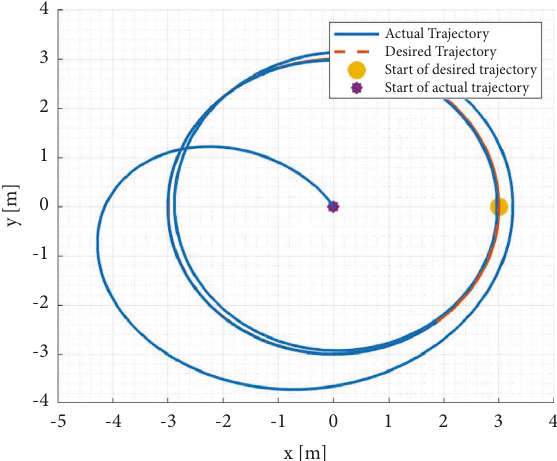
Figure 11: Desired and actual trajectories with PD Controller.